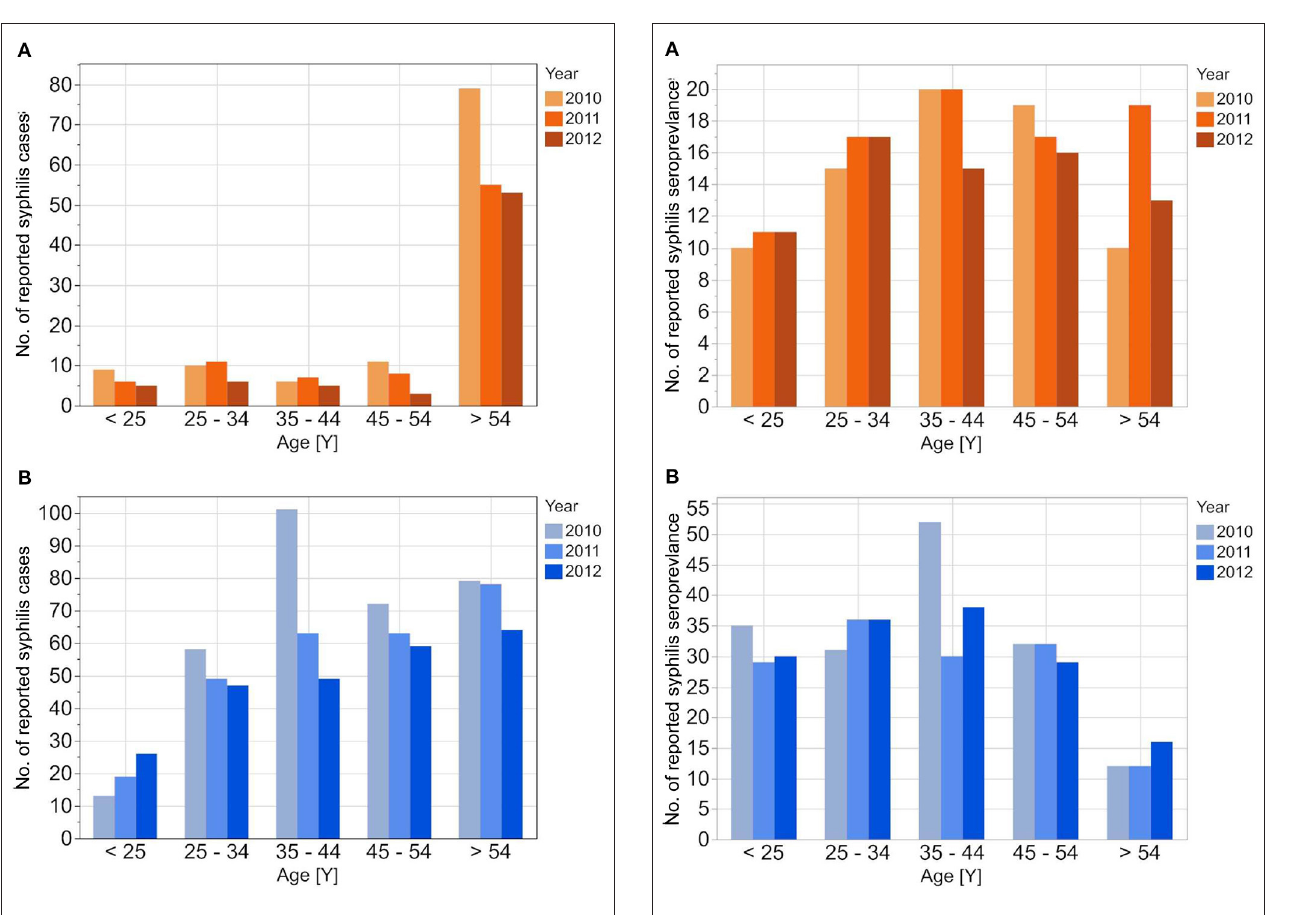
FIGURE 2 | Age stratified reported incidences of syphilis in DAK-G insurance data set from 2010 to 2012 for the female (A) and the male (B) insured population.